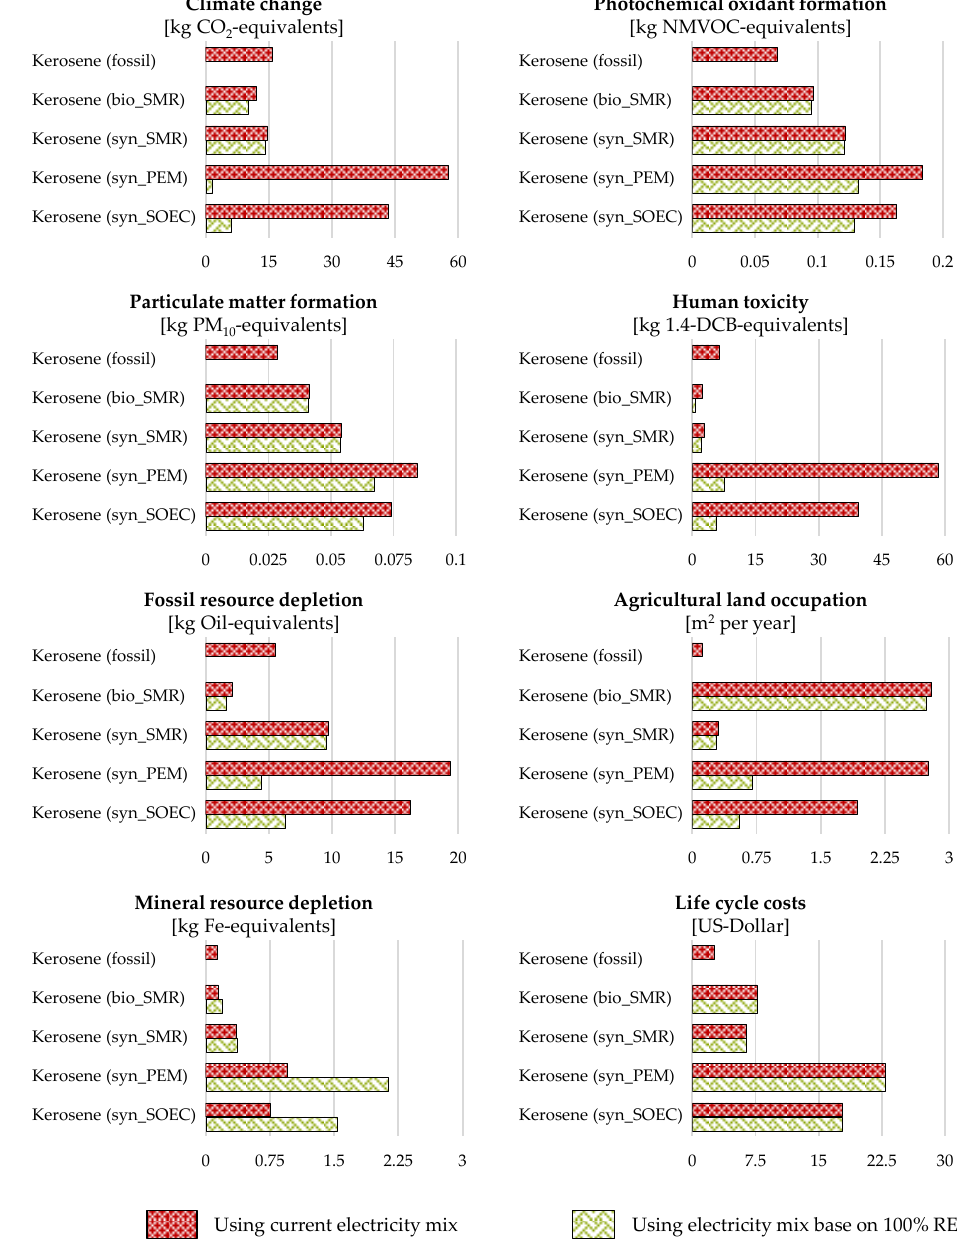
Figure 6. Comparison of the environmental and economic impacts per 100 pkm using the current electricity mix and an electricity mix based on 100% RE in the fuel supply chain of SAFs.